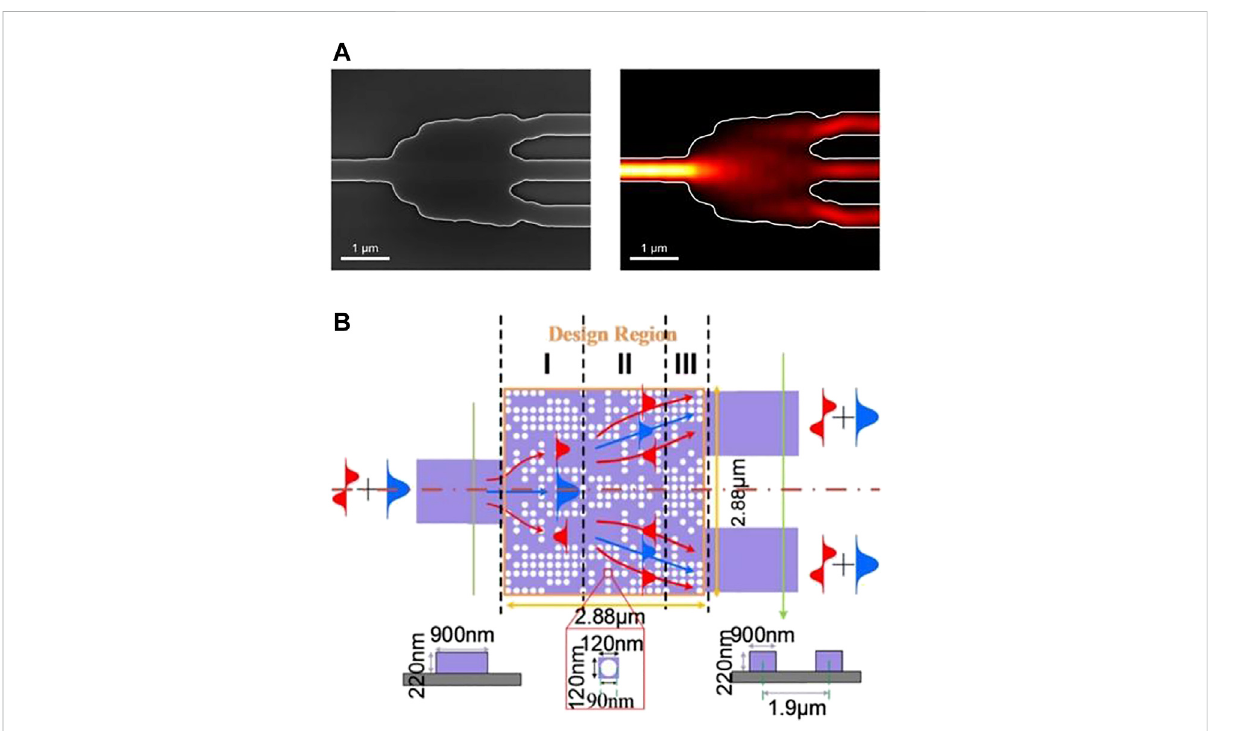
FIGURE 7 Design of beam splitter based on inverse design. (A) Simulation diagram of power splitter based on topology optimization algorithm [77]. (B) Dual mode power splitter based on nonlinear DBS algorithm and topology optimization [78]. Figure reproduced with permission from: (A) , © 2017, Conference on Lasers and Electro-Optics (CLEO); (B) , © 2018, Optical Society of America